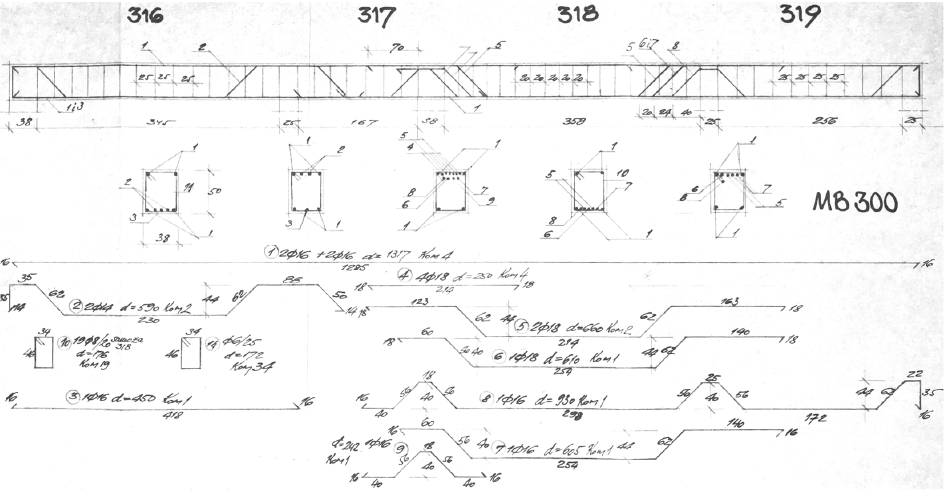
Figure 4. Reinforcement layout form original static design.